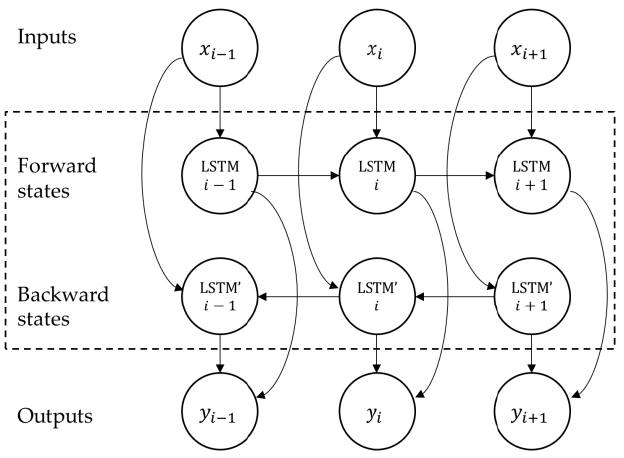
Figure 3 . Diagram of a BLSTM layer. Figure 3. Diagram of a BLSTM